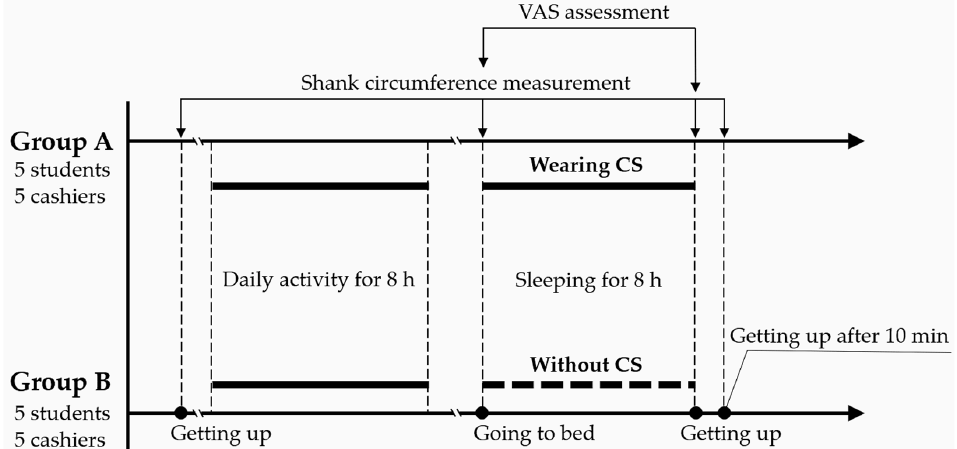
Figure 2. Schematic timeline of the study design (VAS, visual analog scale).